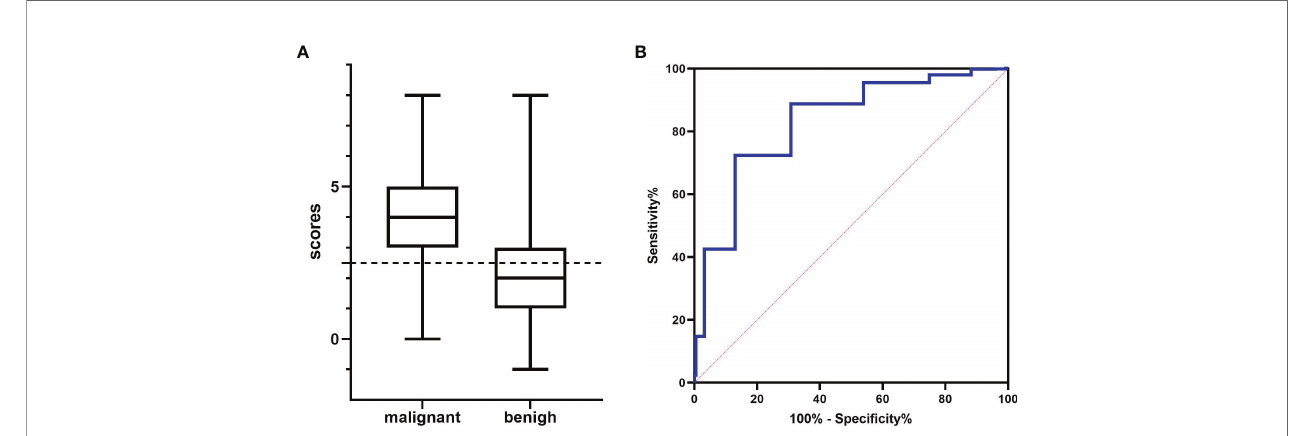
FIGURE 3 | The results for various data scores. (A) Histogram analysis: the cut-off value was 2.5 (dotted line). (B) Receiver operating characteristic (ROC) curve analysis: the largest area under the ROC curve (Az) value was